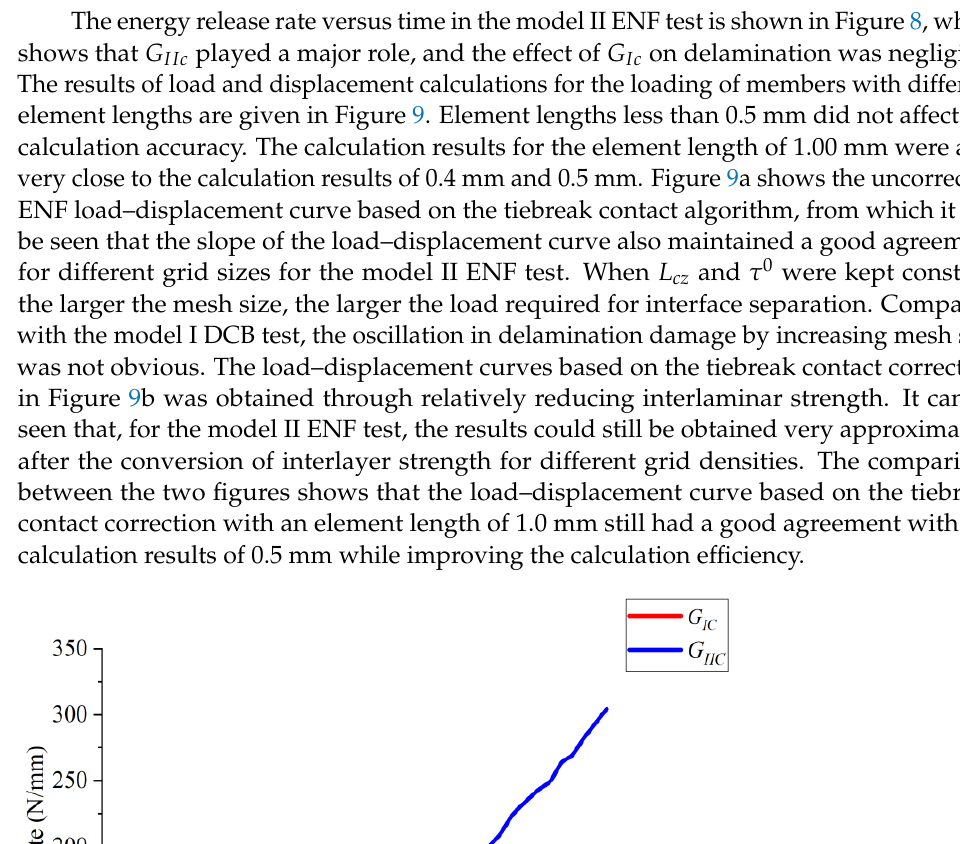
( b ) Figure 9. Model II delamination failure based on the tiebreak contact algorithm correction. ( a ). Un- corrected load – displacement curve; ( b ). corrected load – displacement curve. In both the model I DCB test and the model II ENF test, the error increased with the increase in element length. However, the results for the element length of 1.0 mm showed good similarity with element lengths of 0.5 mm and 0.4 mm. This is in agreement with the findings of Camanho et al., in the literature [26]. 4. Simulation of Cylindrical Partial Delamination Failure of Composite Pressure Ves- sel 4.1. Selection of Materials for In-Plane Damage of Composite Materials When a composite-overwrapped vessel is loaded, delamination failure predomi- nates, and in-plane failure hardly occurs. At this time, the fiber is in the elastic – plastic phase, and a MAT_54 progressive damage model can ideally simulate the elastic – plastic phase of the composite [27].